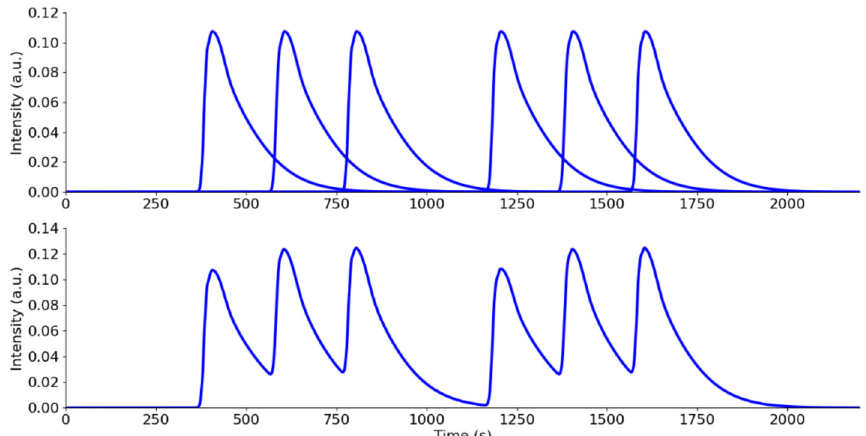
Figure 3. Binary encoded sequence of eight consecutive bits representative of the letter “w” in ASCII language. Signals as they should be without ISI (upper graph), signals as they are with ISI (lower graph).